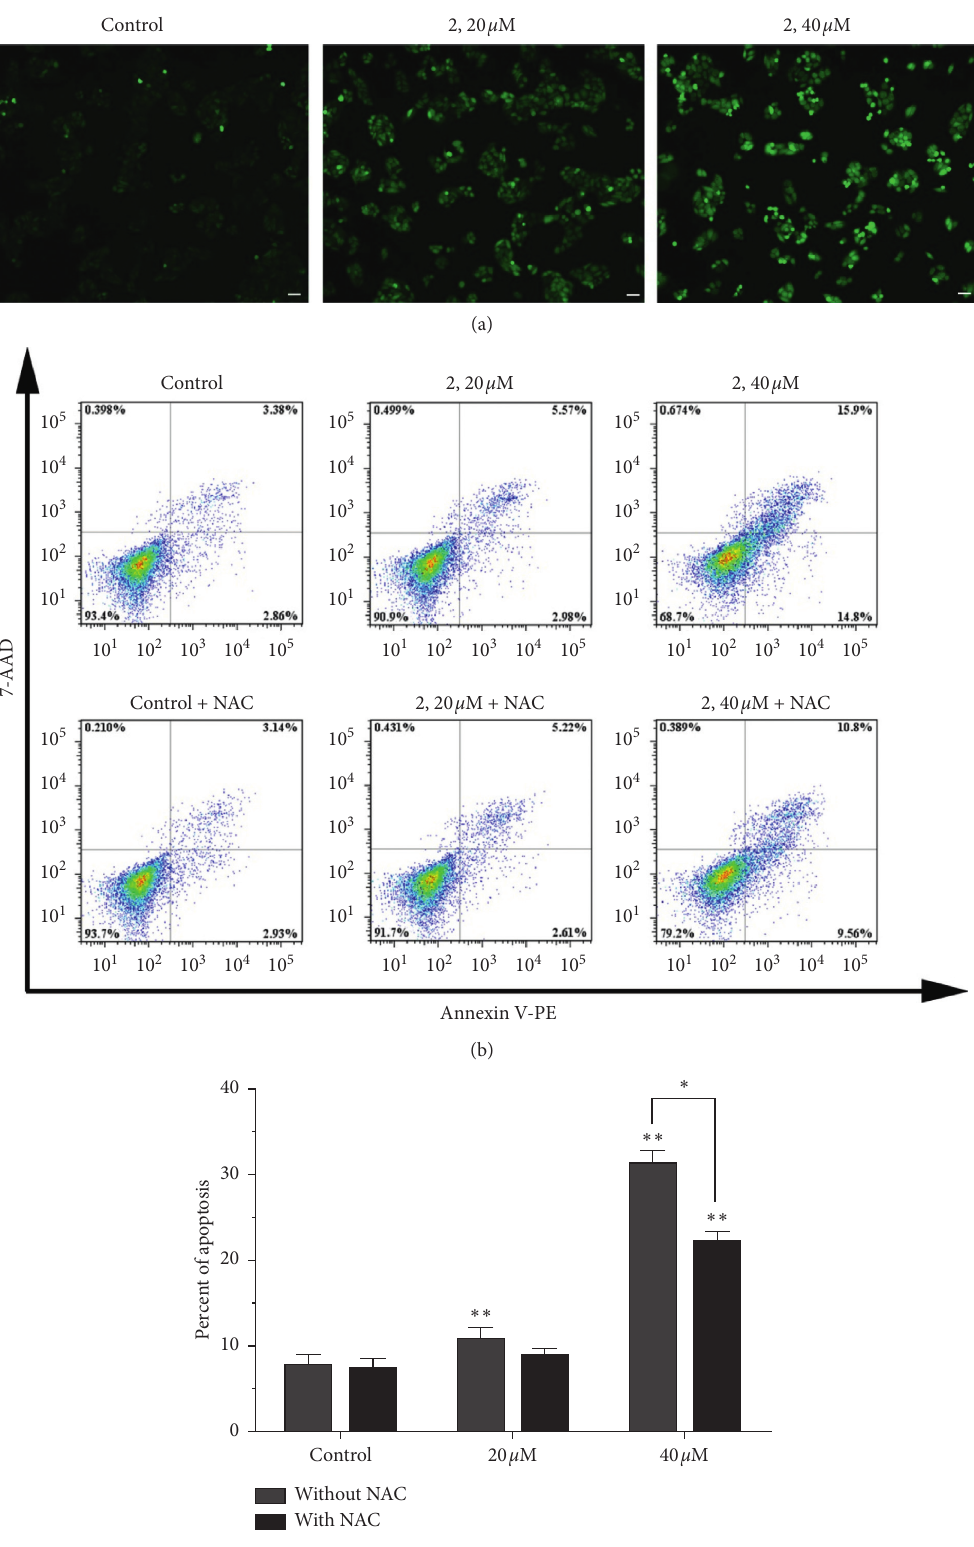
Figure 4: (a) Intracellular ROS was detected in Eca-190 cells after exposure to complex 2 (0, 20, and 40 μ M) for 24h under a fluorescence microscope. Representative photomicrographs from three independent experiments. Scale bars: 20 µ m. (b) Apoptosis of Eca-109 cells was detected by flow cytometry after treated with different concentrations (0, 20, and 40 μ M) of complex 2 for 24h with or without NAC pretreatment. (c) Quantitative data analysis for the number of cells (% of total) in apoptosis for different treatment groups. Data were presented as mean ± SD ( n � 3), Student’s t -test, ∗ P < 0 . 05, ∗∗ P < 0 .